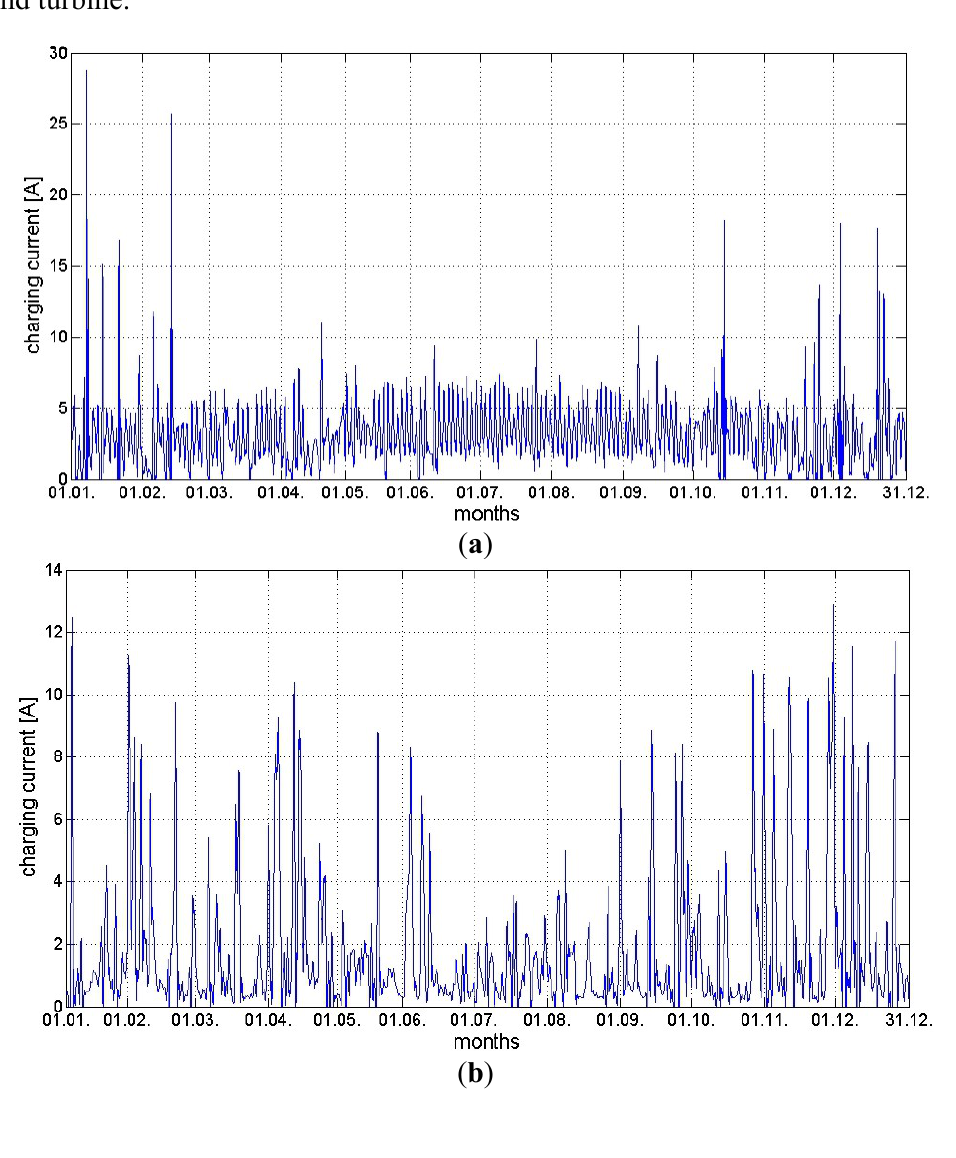
Figure 12. Variation of charging current on the BSS C during a year for: ( a ) one solar array; ( b ) wind